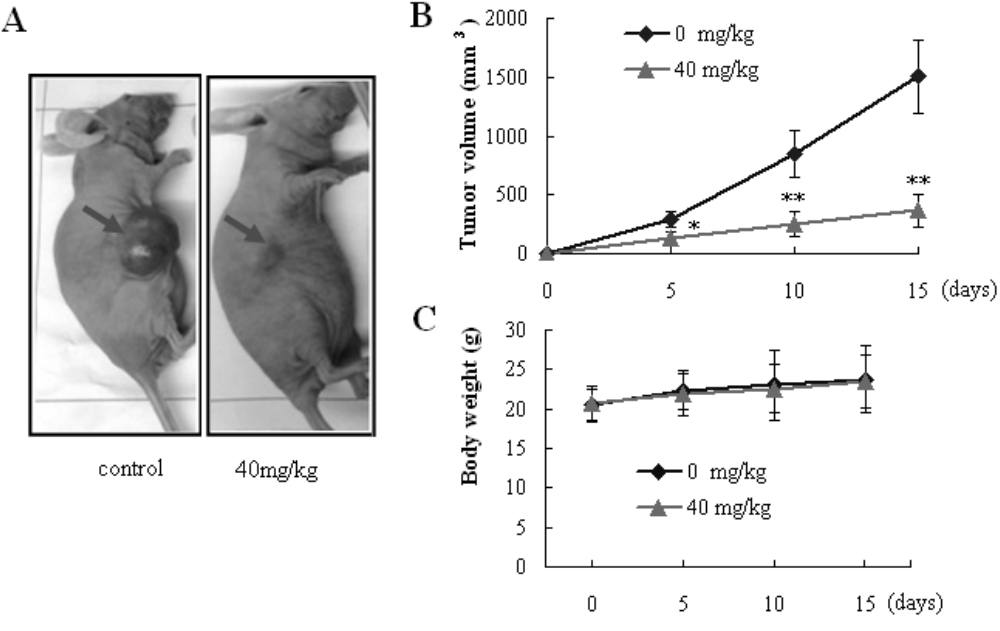
Figure 7. SBT-A showed antitumor activity on A549 tumor-bearing nude mice. ( A ) Illustration of a representative tumor after treatment with SBT-A; ( B ) The effect of SBT-A on tumor volumes; ( C ) The effect of SBT-A on the weights of A549 tumor-bearing nude mice. The data are represented as mean ± S.D ( n = 10). * p < 0.05 and ** p < 0.01 vs. control.